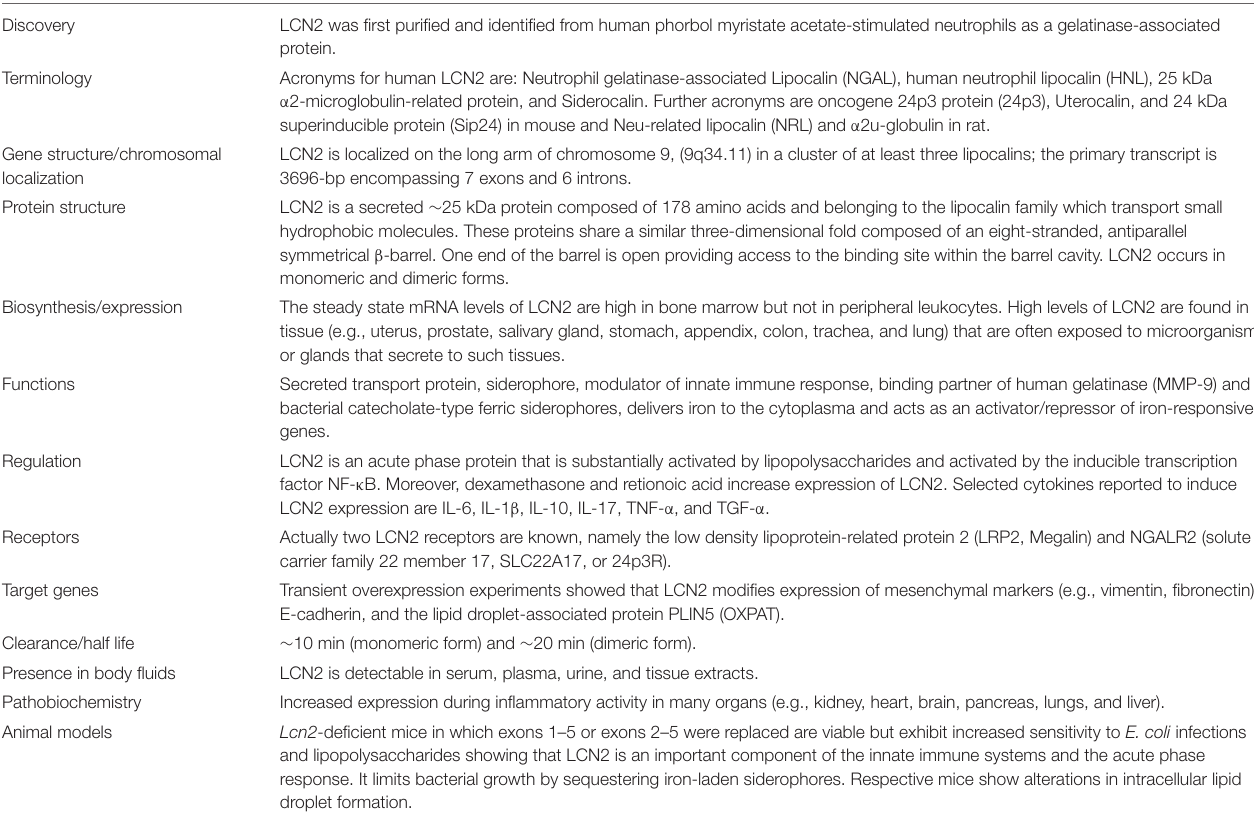
TABLE 1 | Compilation of data on structure and function of LCN2.